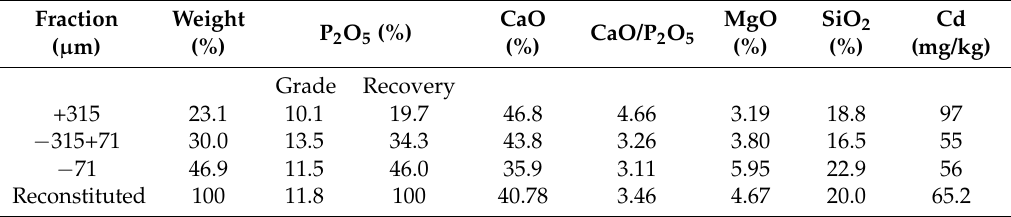
Table 5. Chemical analysis of scrubbed sample.